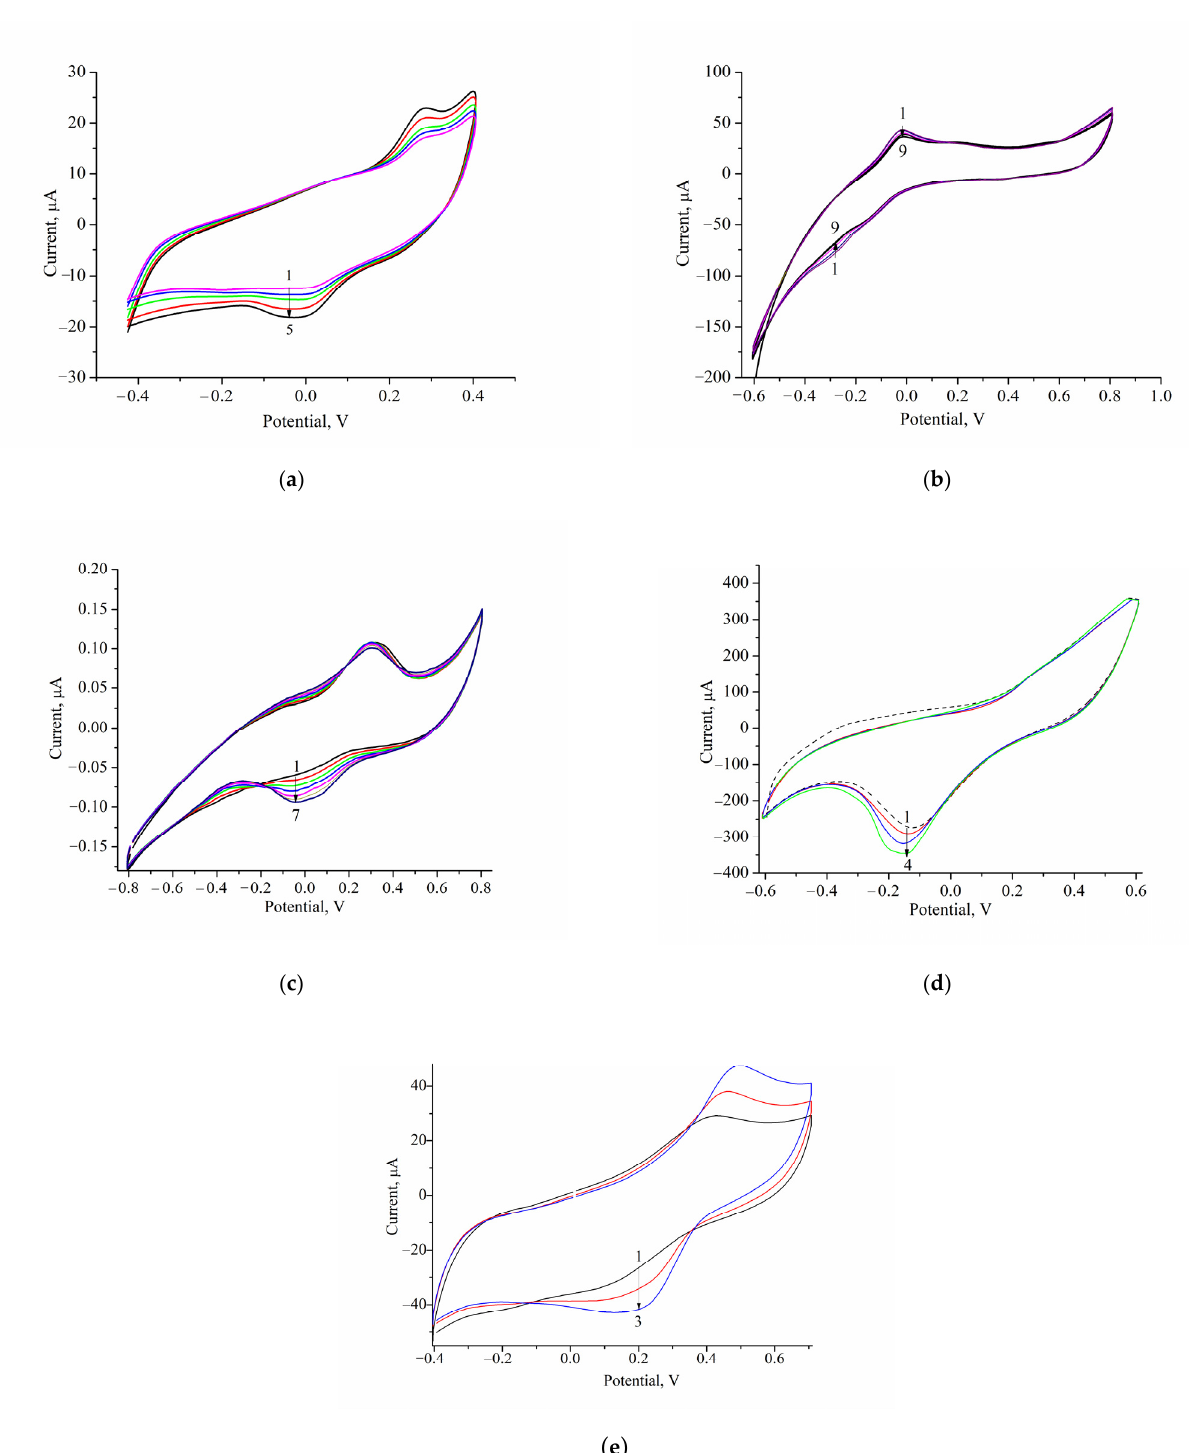
Figure 3. Profiles of CVs for the nCuCe/GEs, modified with GO ( a ), AMO ( b ), AO ( c ), ArgO ( d ), and laccase ( e ). Conditions: Ag/AgCl (reference electrode); 50 mM phosphate buffers (PB), pH 6.0 ( a ), pH7.5 ( b – d ), and NaOAc buffer, pH 4.5 ( e ); scan rate − 50 mV·s − 1 . Substrates were added up to concentrations: 0–4 mM glucose, lines 1–5, respectively ( a ); 0–1 mM MA, lines 1–4, respectively ( b ); 0–2 mM methanol, lines 1–7, respectively ( c ); 0–13 mM L-Arg, lines 1–4, respectively ( d ); 0–1 mM catechol, lines 1–3, respectively ( e ).